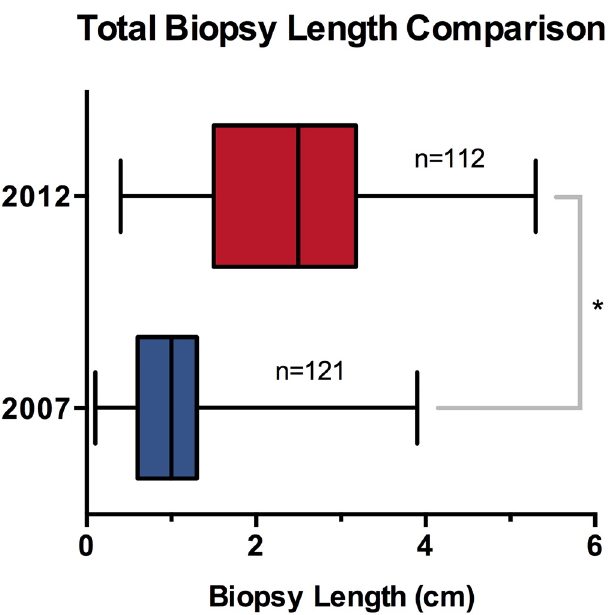
Fig 1. Box and whiskers (25% – 75%) plot of total biopsy sample size comparing 2007 (blue) and 2012 (red). * P < 0.0001 (Mann-Whitney U test).